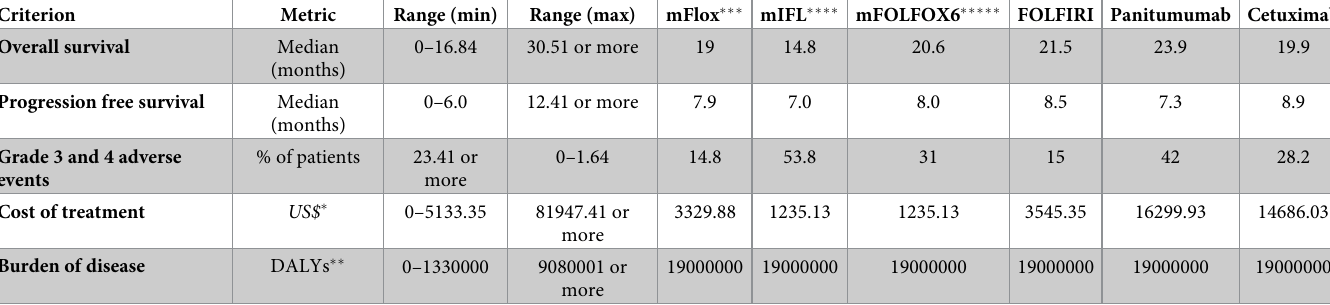
Table 4. Performance matrix of options across